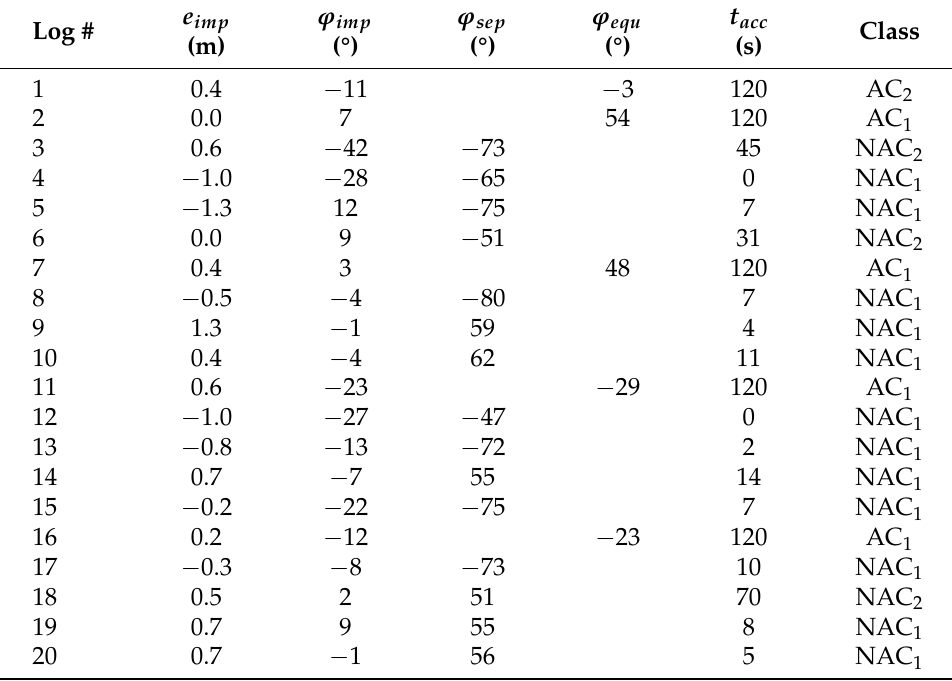
Table A1. List of all n = 55 logs with the observation parameters and their classification as AC 1 , AC 2